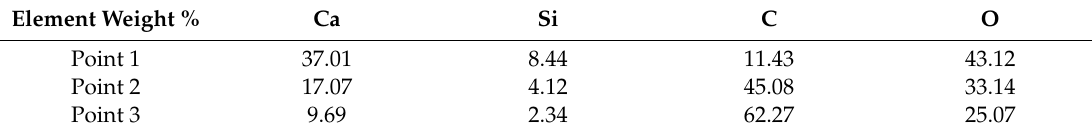
Table 5. Mass Distribution of Major Elements in Di ff erent Regions.